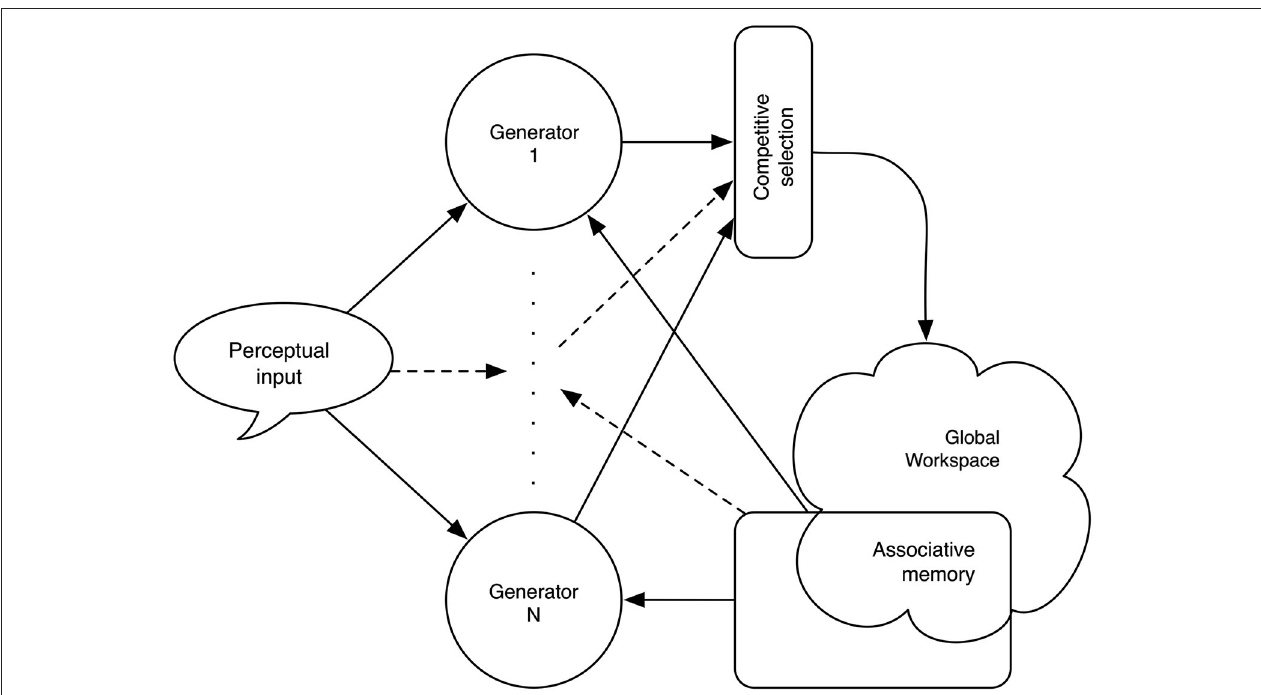
FIGURE 3 | Schematic diagram of Wiggins (2012b) proposal for the Global Workspace . In this version, there is no need for a threshold of access. Instead, the generators compete one against another and probability and information content determine the